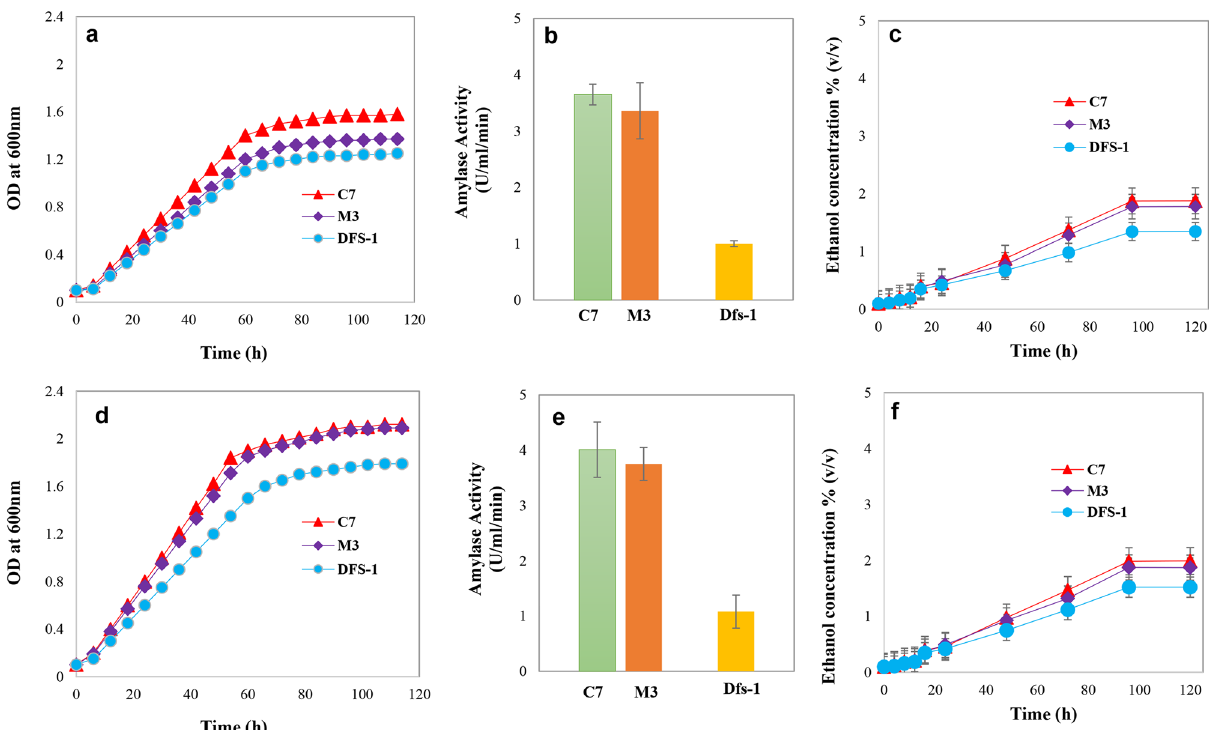
Figure 4. Growth pattern, amylolytic activity and ethanol production ability (%) of adapted strains from starch fermentation. Here ( a–c ) and ( d – f ) represents 37 °C and 42 °C respectively. High temperature and substrate (starch) adaptation process are illustrated in the “Methods” section. Samples were collected at 6-h intervals, put on an ice bucket to seize the growth. Subsequently, their growth was measured by a spectrophotometer at 600 nm against the YPS broth as blank. For ethanol concentration measurement, samples were taken at 0 h, 4 h, 8 h, 12 h, 16 h, 24 h, 48 h, 72 h, 96 h and 120 h intervals from starch fermentation broth